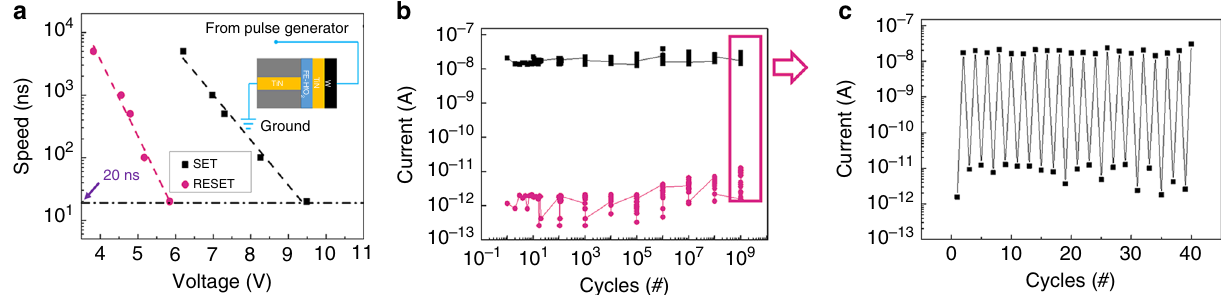
Fig. 5 Ultrahigh speed and high endurance. a Voltage dependence of the SET and RESET operation speed for Fe-diode memory. The inset shows a schematic of the device structure with the pulse signal. b Endurance test. The device can switch >10 9 pulse cycles. c For each order of the cycling number, 20 cycles of write-and-read operation were carried out to con fi rm the effectiveness of the write pulses.